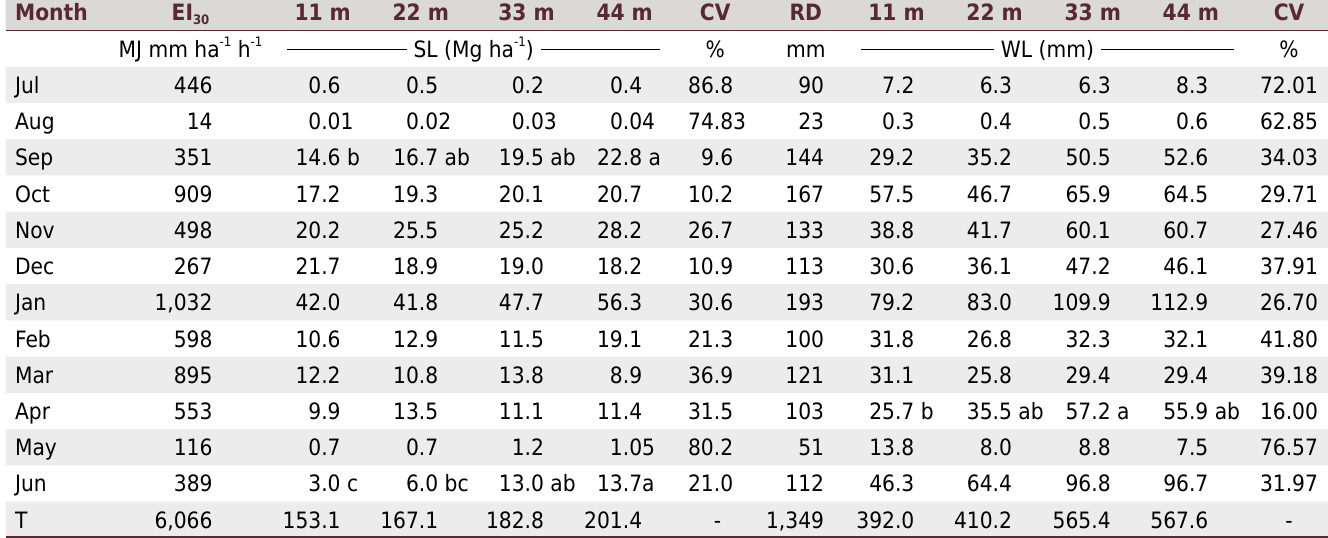
Table 2. Values of erosivity (EI 30 ), soil loss (SL), rain depth (RD), and water loss (WL) obtained from July 2014 to June 2015 and annual total (T), in different treatments (average of